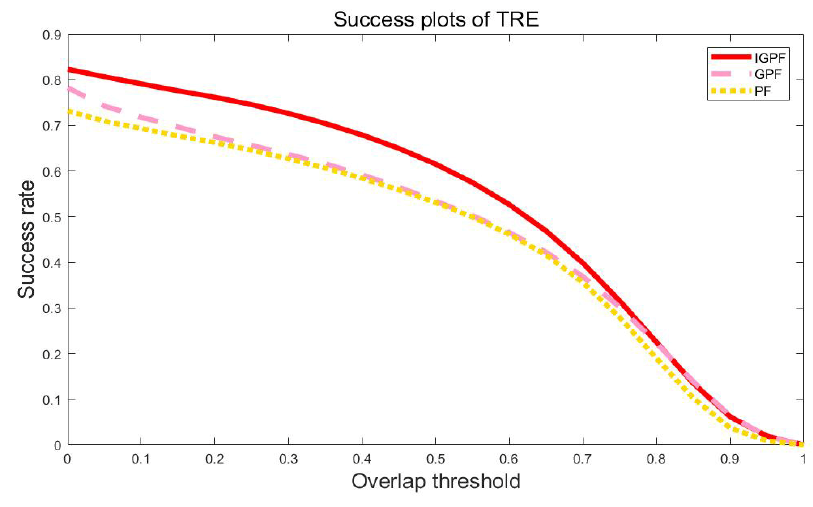
Figure 6. OS TRE curve.